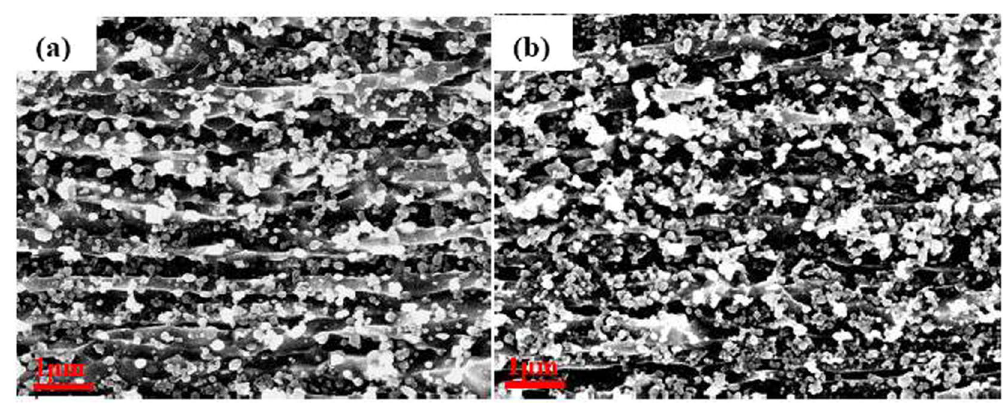
Figure 2. Scanning electron micrographs of ( a ) UFG-1 and ( b ) UFG-2